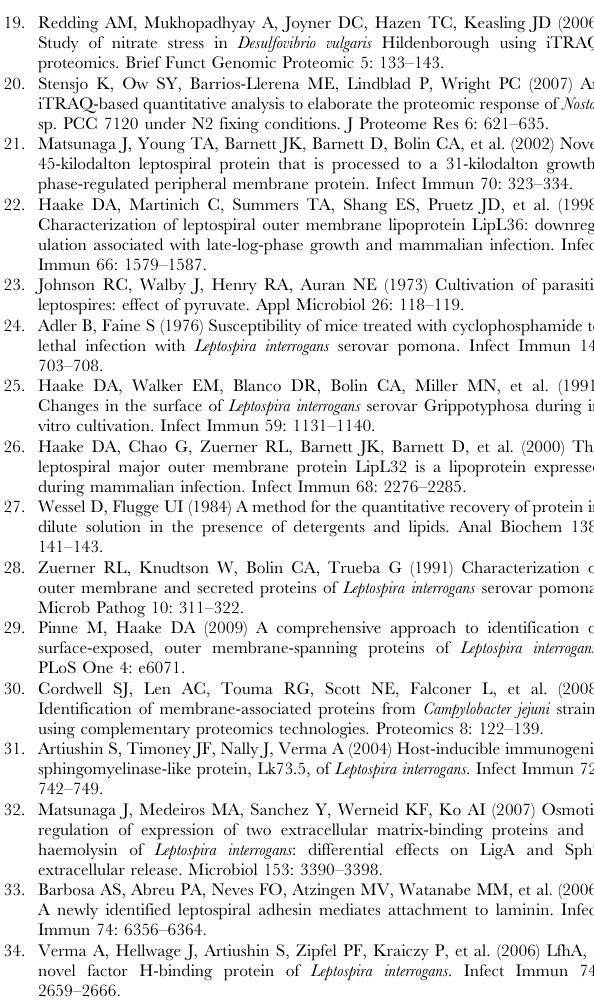
Table S1 Supplementary table of all proteins